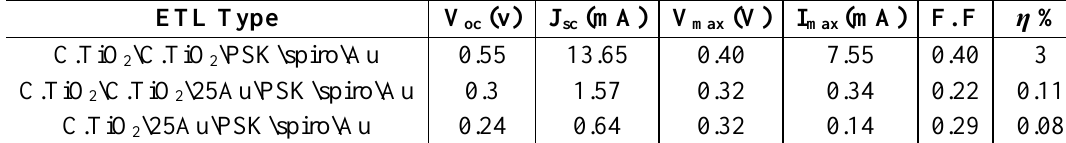
Table 1: Perovskite solar cell with thin Au layer between ETL and PSK Parameters.